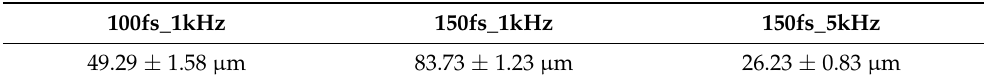
Table 2. Extent of the debris and oxide layer present outside the lines cut by the laser for the different laser parameters.